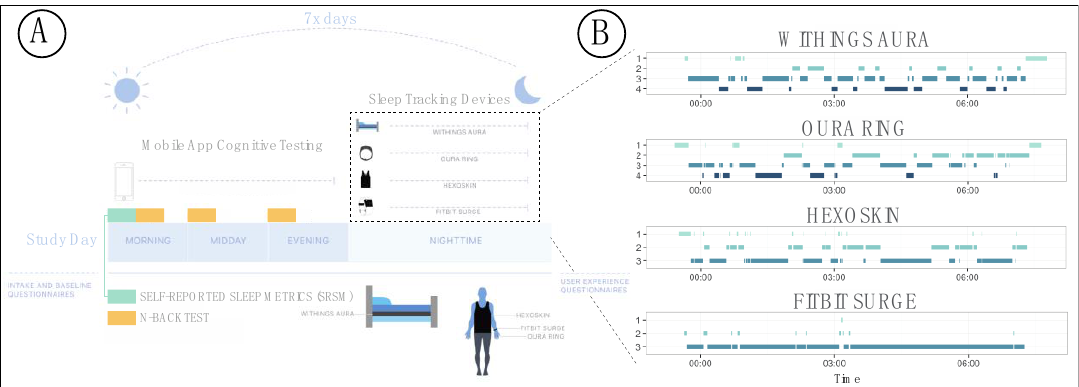
Figure 1. Study structure and data collection for our pilot sleep study. ( a ) Illustration of sleep study monitoring procedure and data collection strategies. ( b ) Example data showing a comparison of sleep staging of a single night for one study participant for all four devices.